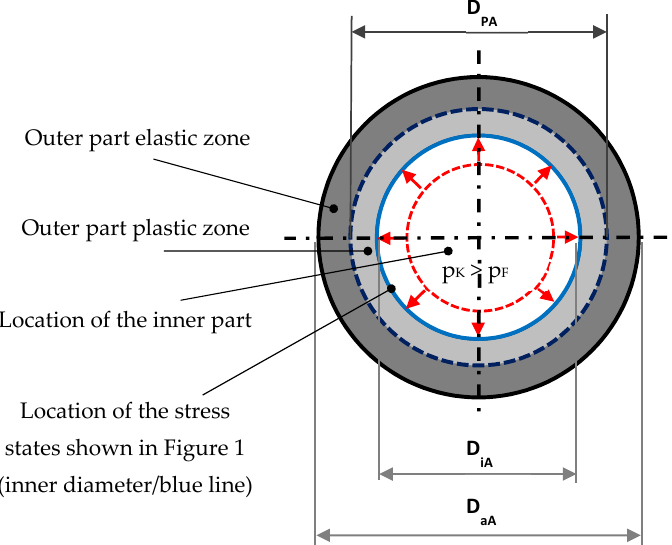
Figure 2. Plastic conditioning of a hub by the application of a conditioning pressure, p K [6].